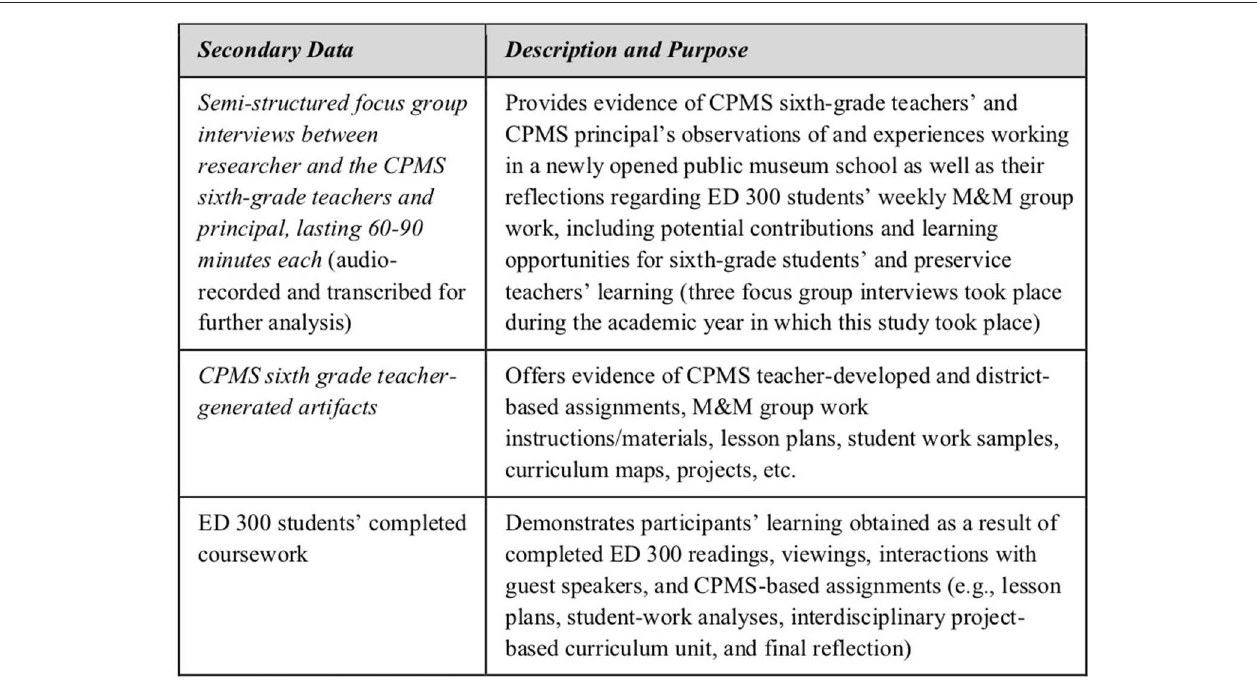
FIGURE 4 | Secondary data